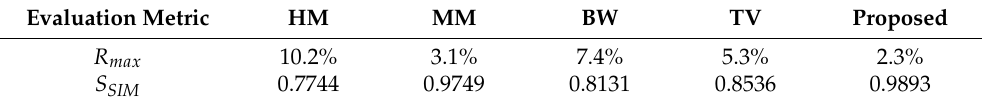
Figure 12. Longitudinal averages of the MMS V-NIR (central wavelength of 950.9 nm) simulation and denoised data. Table 2. Comparison of the objective indicators for the simulated images shown in Figure 8.